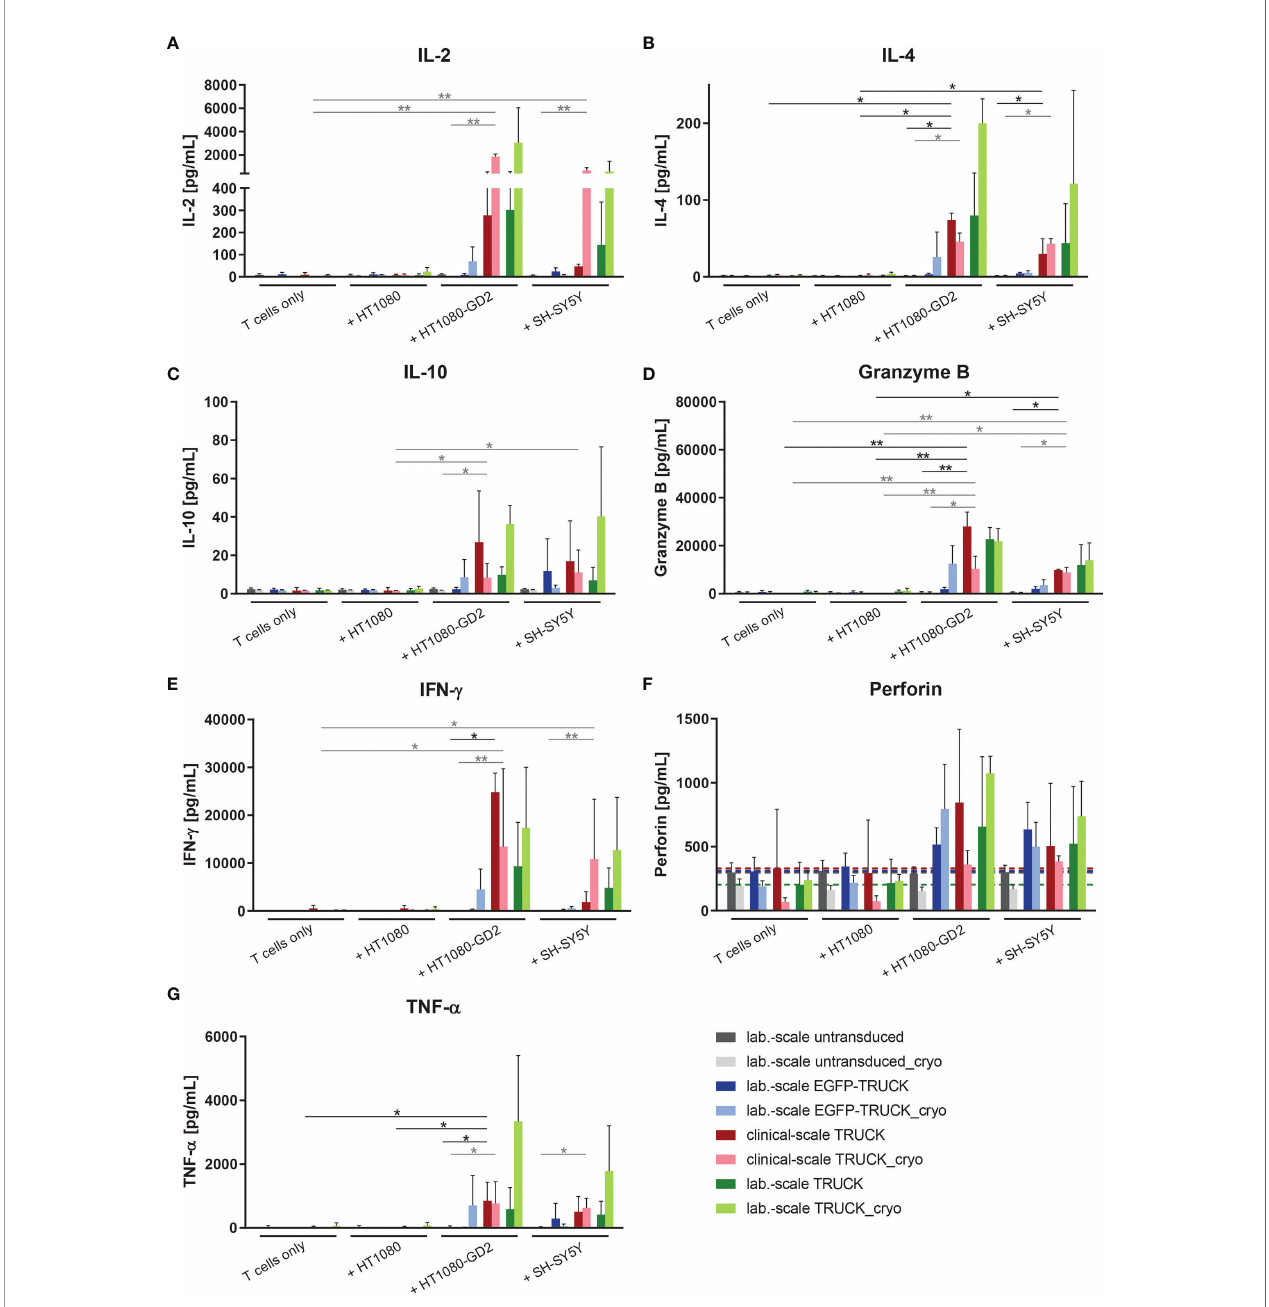
FIGURE 5 | Clinical-scale-manufactured IL-18 TRUCKs targeting GD 2 speci fi cally react to target recognition with increased release of soluble mediators. IL-18 TRUCKs targeting GD 2 were generated using the CliniMACS Prodigy ® (clinical-scale TRUCK; n=2) or under laboratory conditions (lab.-scale TRUCK; n=3). Untransduced T cells (lab.-scale untransduced; n=3) as well as GD 2 TRUCKs with inducible EGFP expression (EGFP-TRUCK; n=3) served as control. The manufactured cells were tested for functionality either directly after the generation process (d12) or after cryopreservation and thawing (cryo) by co-cultivation with the indicated target cells in an effector-to-target (E:T) ratio of 8:1 or cultivation of T cells only. The concentration of released cytokines (A) IL-2, (B) IL-4, (C) IL-10, (D) granzyme B, (E) IFN- g , (F) perforin, and (G) TNF- a in the cell culture supernatants after 48 h was assessed by LEGENDPlex ™ . (F) A dashed line indicates background levels of the respective cytokine release by untransduced T cells (grey), EGFP-TRUCKs (blue), as well as clinical-scale (red) and laboratory-scale (green) TRUCKs cultured alone. (A – G) Data are shown as mean ± SD. Statistical differences of clinical-scale TRUCKs co-cultured with different target cells after generation or cryopreservation as well as in comparison to all laboratory-scale manufactured cells were assessed by Kruskal-Wallis and Dunn ’ s test, signi fi cant differences are shown (*p ≤ 0.05, **p ≤